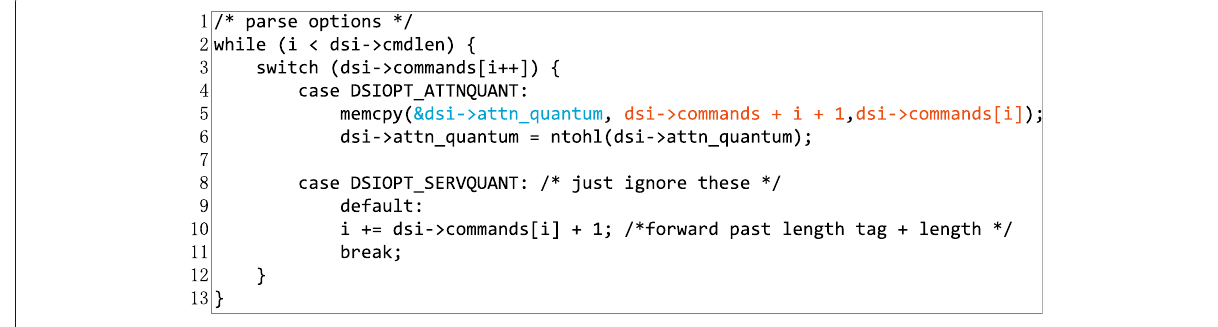
MRR(with offset 0). So when the MRR(with offset 0) to write the MRR(with offset max length), MAI will report an OOB error which is a false positive. Another example is using different operations to write an int array. When the array is initialized, the program uses the following code in Fig. 16. For each int variable, we give it an MRR that can access 8 bytes, but this array is used later. The source code is shown in Fig.